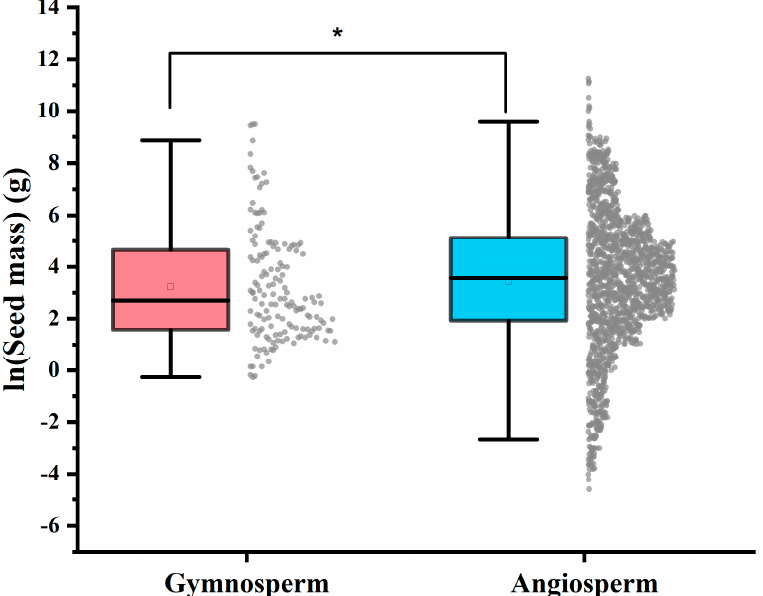
Figure 2. Box diagrams of seed mass distribution. There was a significant difference between gymnosperms ( n = 175) and angiosperms ( n = 2572) in the overall comparison ( p < 0.05). Red indicates gymnosperms, blue indicates angiosperms. The horizontal lines represent the 25%, 50%, and 75% quantiles. The vertical lines show the 5% and 95% quantiles. Asterisks above the horizontal line indicate significant differences among gymnosperm and angiosperm ( p < 0.05).